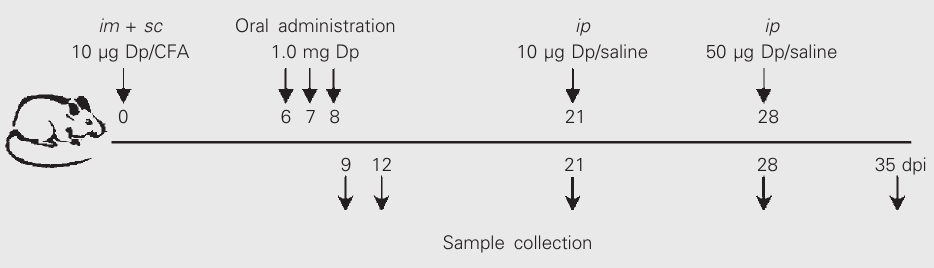
Figure 1. Immunization sched- ule of Dermatophagoides ptero- nyssinus (Dp) extract and oral administration to mice. Samples (cells, sera and fecal extracts) were obtained at different times after immunization with the Dp (see Material and Methods). CFA = complete Freund’s adju- vant; dpi = days post-immuniza-